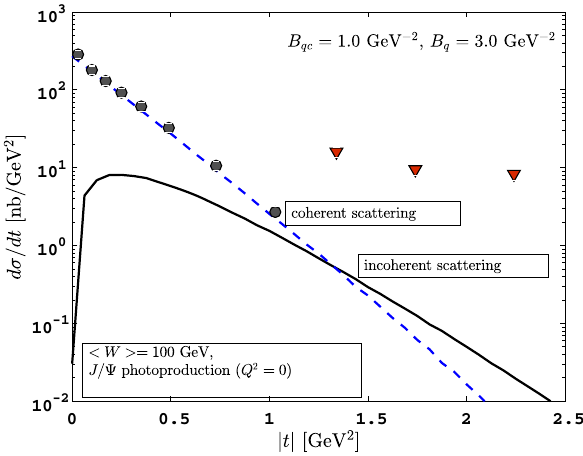
Fig. 5 Coherent and incoherent J /Ψ photoproduction cross section at (cid:4) W (cid:5) = 100 GeV. The full line shows the result for the incoherent scattering using the “smooth” configuration parameters (see legend and Fig. 2). Data as in Fig. 4